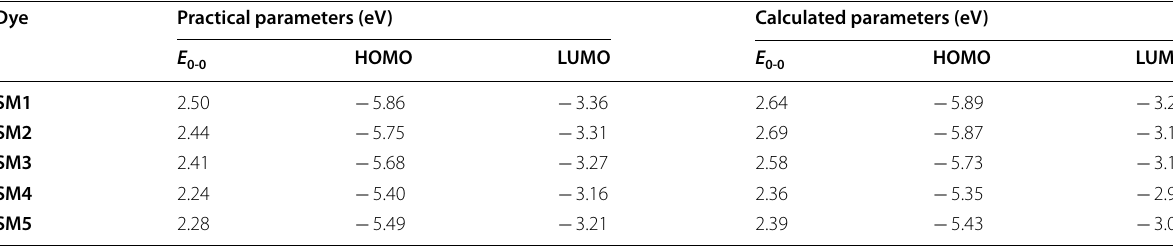
Table 2 Electrochemical data for dyes SM1-5 Dye Practical parameters